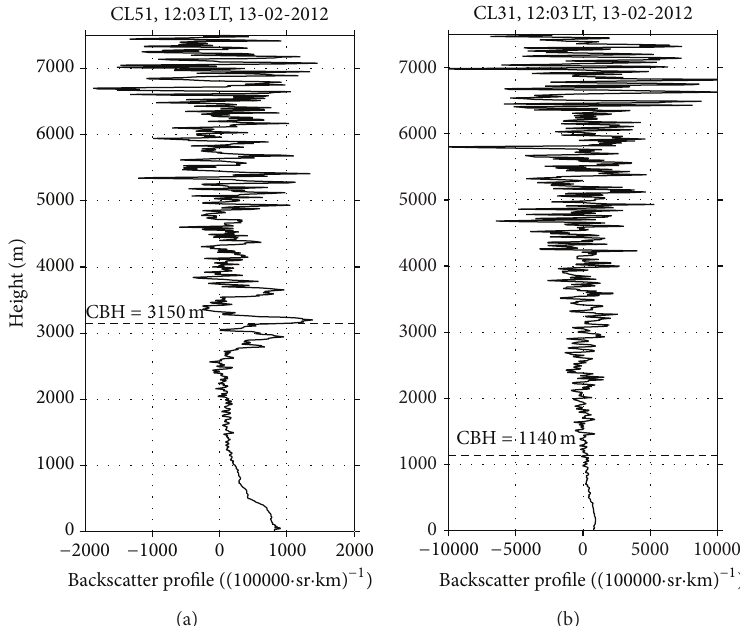
Figure 4: Vertical profiles of the attenuated backscatter coefficient from both ceilometers (13 February 2012): (a) Vaisala CL51 and (b) Vaisala CL31.